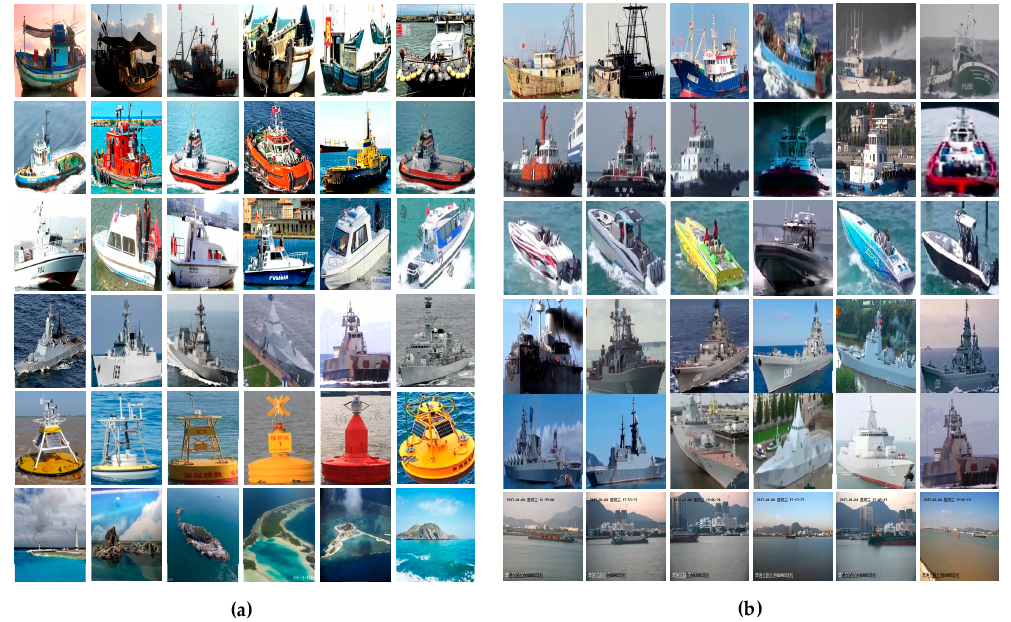
Figure 3. Samples of self-built dataset: ( a ) Examples of images that are downloaded from the website; ( b ) examples of images that are collected from real scenes and intercepted from videos.